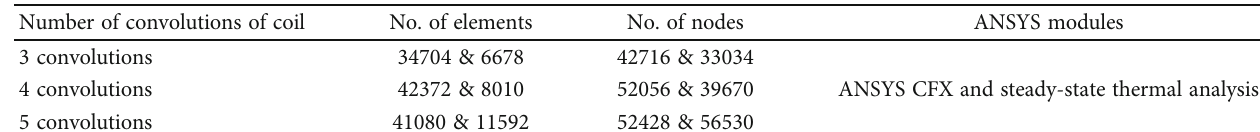
Table 2: Description of mesh data.